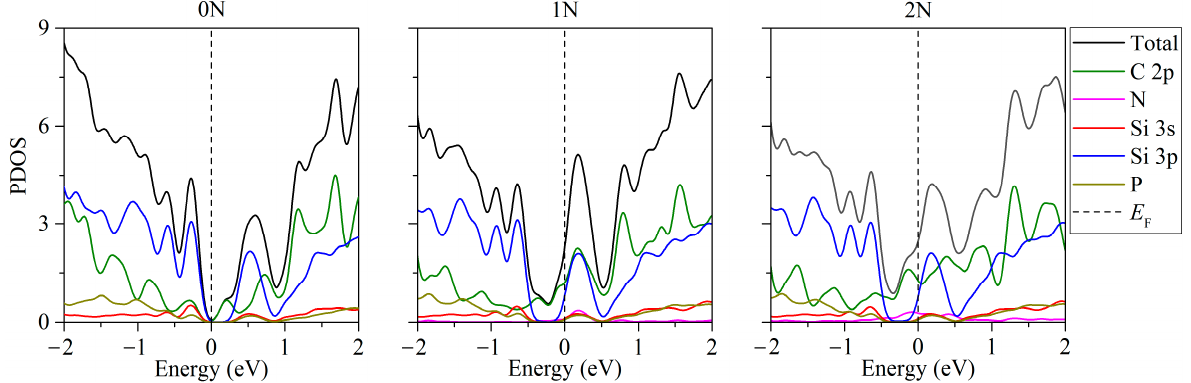
Figure 7. Partial densities of electronic states of doped two-layer silicene/graphite substrate systems in the presence of 2 P atoms in silicene.